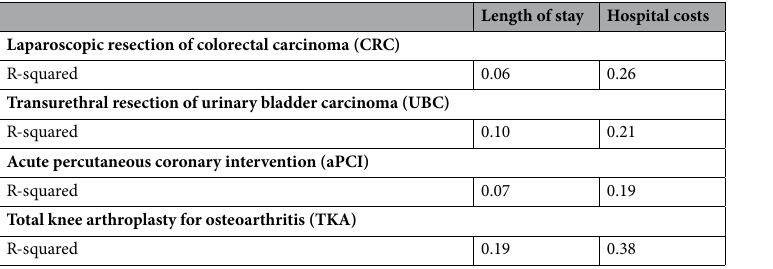
Length of stay Hospital